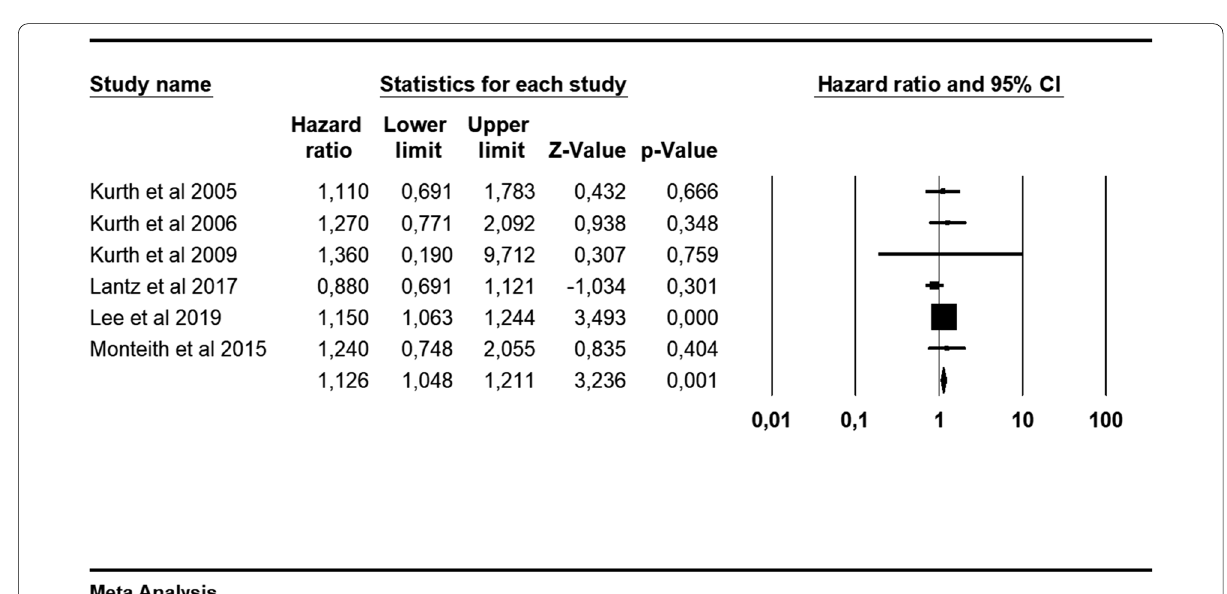
Fig. 4 Random-effect models meta-analysis for migraine without aura and ischemic